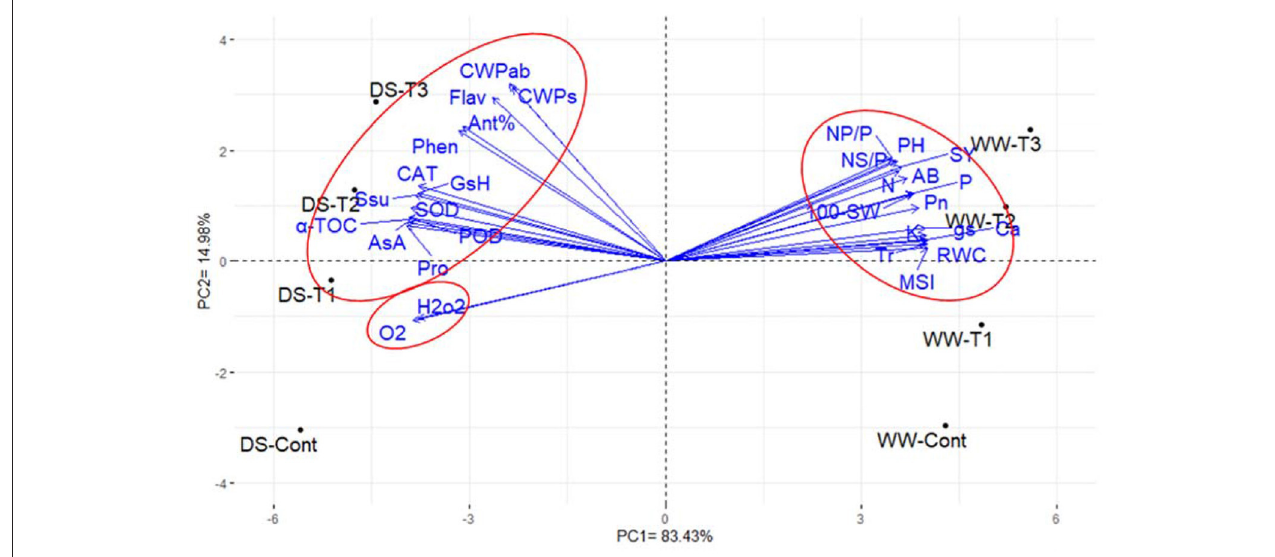
FIGURE 2 | Biplot of the first two principal components for the physiological, biochemical, and agronomic traits of faba beans ( Vicia faba ). The physiological parameters comprised of net photosynthetic rate ( Pn ), transpiration rate ( Tr ), stomatal conductance ( gs ), relative water content (RWC), membrane stability index (MSI), nitrogen (N), phosphorus (P), potassium (K), calcium (Ca) content, proline content (Pro), soluble sugars (SSu), peroxidase activity (POD), catalase activity (CAT), superoxide dismutase activity (SOD), ascorbic acid (AsA), glutathione (GsH), hydrogen peroxide (H 2 O 2 ), superoxide radical (O . − 2 ), and α -tocopherol ( α -TOC). The biochemical parameters included antioxidant activity % (Ant%), flavonoids content (Flav), and phenolic content (Phen). The agronomic traits were plant height (PH), number of pods plant − 1 (NP/P), number of seeds pod − 1 (NS/P), 100-seed weight (100-SW), seed yield (SY), aboveground biomass (AB), crop water productivity for seed yield (CWPs), and aboveground biomass (CWPab). WW-Cont, WW-T1, WW-T2, and WW-T3 were foliar applications using tap water, 0.5, 1, and 1.5mM of nano-silicon dioxide (nano-SiO 2 ) under the well-watered treatment, respectively. DS-Cont, DS-T1, DS-T2, and DS-T3 were foliar applications using tap water, 0.5, 1, and 1.5mM of nano-SiO 2 under the drought stress